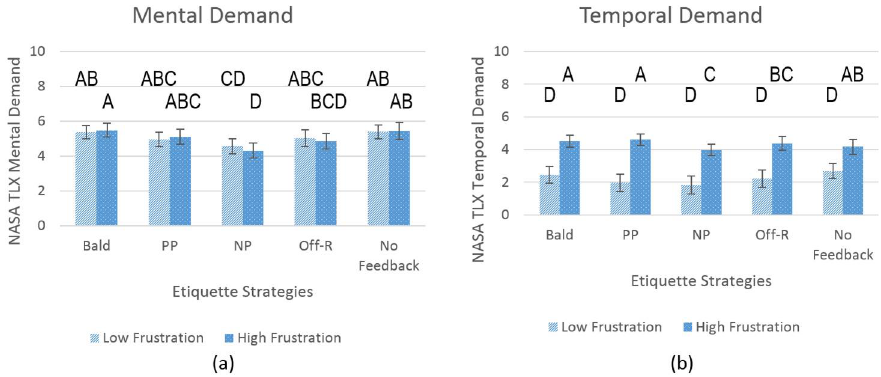
Figure 8. Mean and standard error of TLX ( a ) mental demand and ( b ) temporal demand ( n = 40).